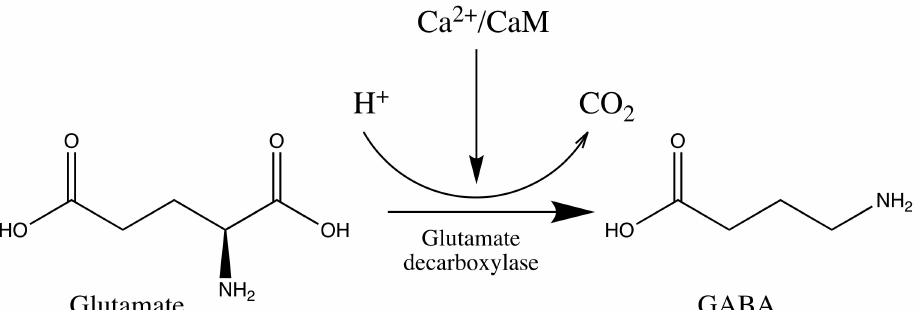
Figure 2. γ -aminobutyric acid (GABA) is produced by glutamate decarboxylate of